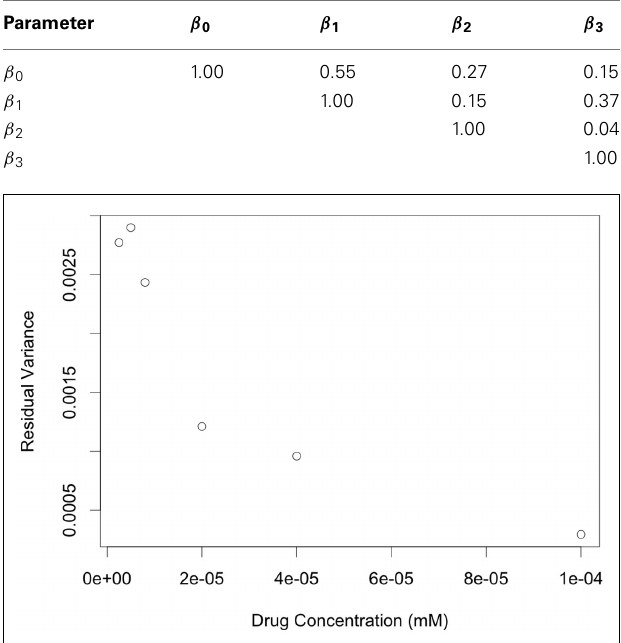
Table 5 | Sample Spearman rank correlations between estimates of hill slope parameters for dose-response curves simulated under H 0 with a MAF of 0.25 and equally spaced drug concentrations.